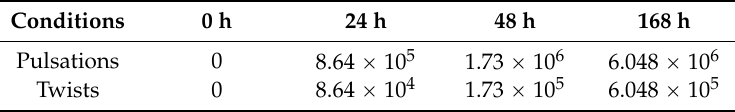
Figure 18. The twist process applied to the stent ‐ grafts. The 35° Z ‐ stent ( A1 ), 45° Z ‐ device ( B1 ) and the ringed device ( C1 ) behave dramatically different. When the gear rotates towards the right, one end of the device is turned anticlockwise ( A2 , B2 , C2 ) to some twist angle. When the gear rotated towards the left, the devices are returned to their original state ( A3 , B3 , C3 ) firstly, and then to an anticlockwise twist angle ( A4 , B4 , C4 ). The Z ‐ stent devices were more severely distorted than the ringed devices, and thus the distilled water flow was more impaired. Table 4. Number of pulsations and twists.